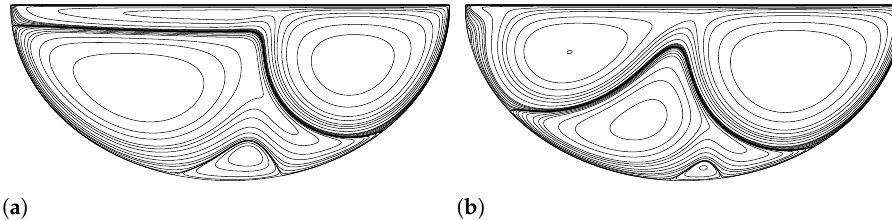
Figure 13. Bifurcation of the solution in driven semi-elliptical cavity flow with D = 0.8 aspect ratio. ( a ) Re = 7181 (1st solution). ( b ) Re = 7182 (2nd solution).